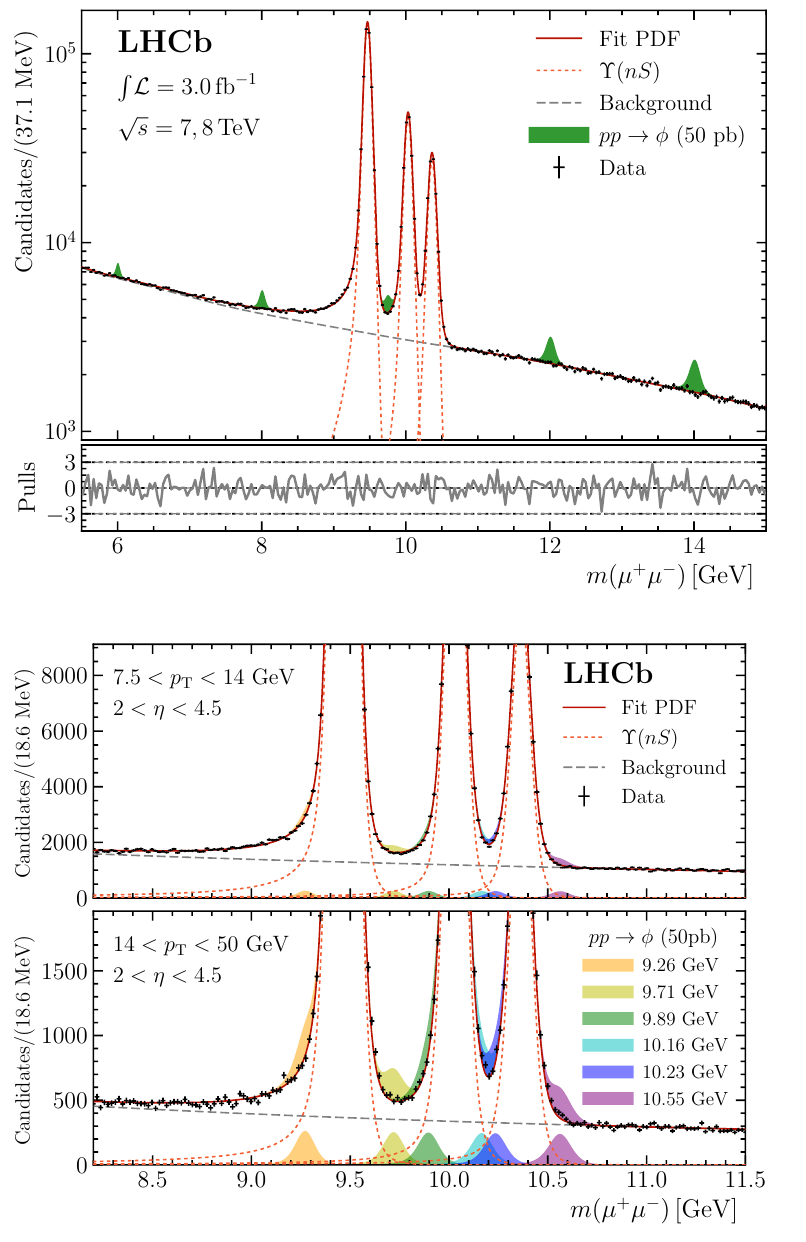
Figure 3 . (Top) Fit to the dimuon invariant mass distribution in the whole scanned region. All [ p T ; (cid:17) ] bins as well as the 7 and 8 TeV data sets are combined. Peaks for (cid:12)ve (cid:30) boson mass hypotheses are displayed in green, assuming (cid:27) ( pp (cid:30) ) ( (cid:30) (cid:22) + (cid:22) (cid:0) ) = 50 pb. (Bottom) A closeup view ! (cid:2) B ! of the mass spectrum in the (cid:7)( nS ) region together with (cid:30) boson mass peaks for the tested m ( (cid:30) ) values closest to the three (cid:7)( nS ) narrow resonances. To show how the (cid:7)( nS ) mass tails change with the kinematics, two regions of p T are displayed in the plot.